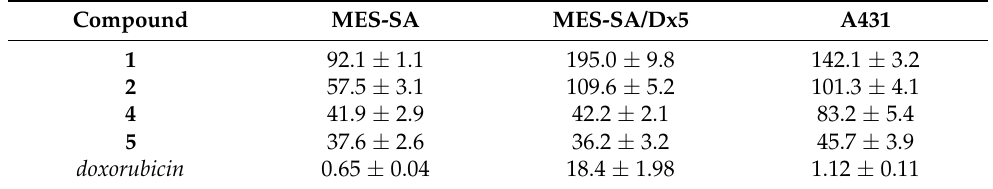
Table 3. IC 50 cytotoxicity values ( µ M) of isolated compounds and the reference compound against uterine sarcoma (MES-SA, MES-SA/Dx5) and epidermoid carcinoma (A431) cell lines. Compound